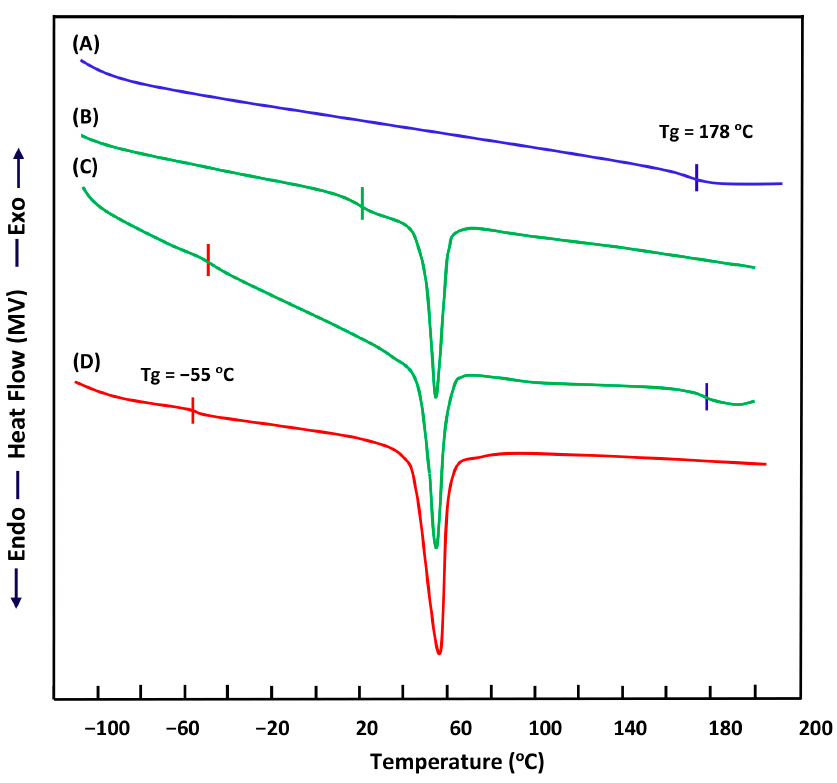
Figure 5. DSC thermograms of: (A) pure PHPMC; (B) PEO/PHPMC-70; (C) PEO/PHPMC-30 and (D) pure